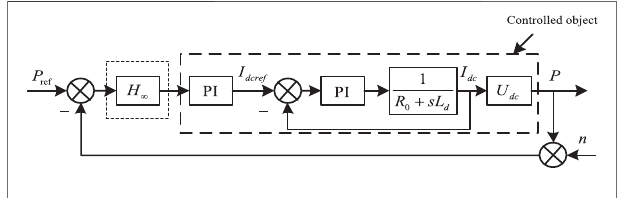
FIGURE 3 | Block diagram of constant power control of chopper.